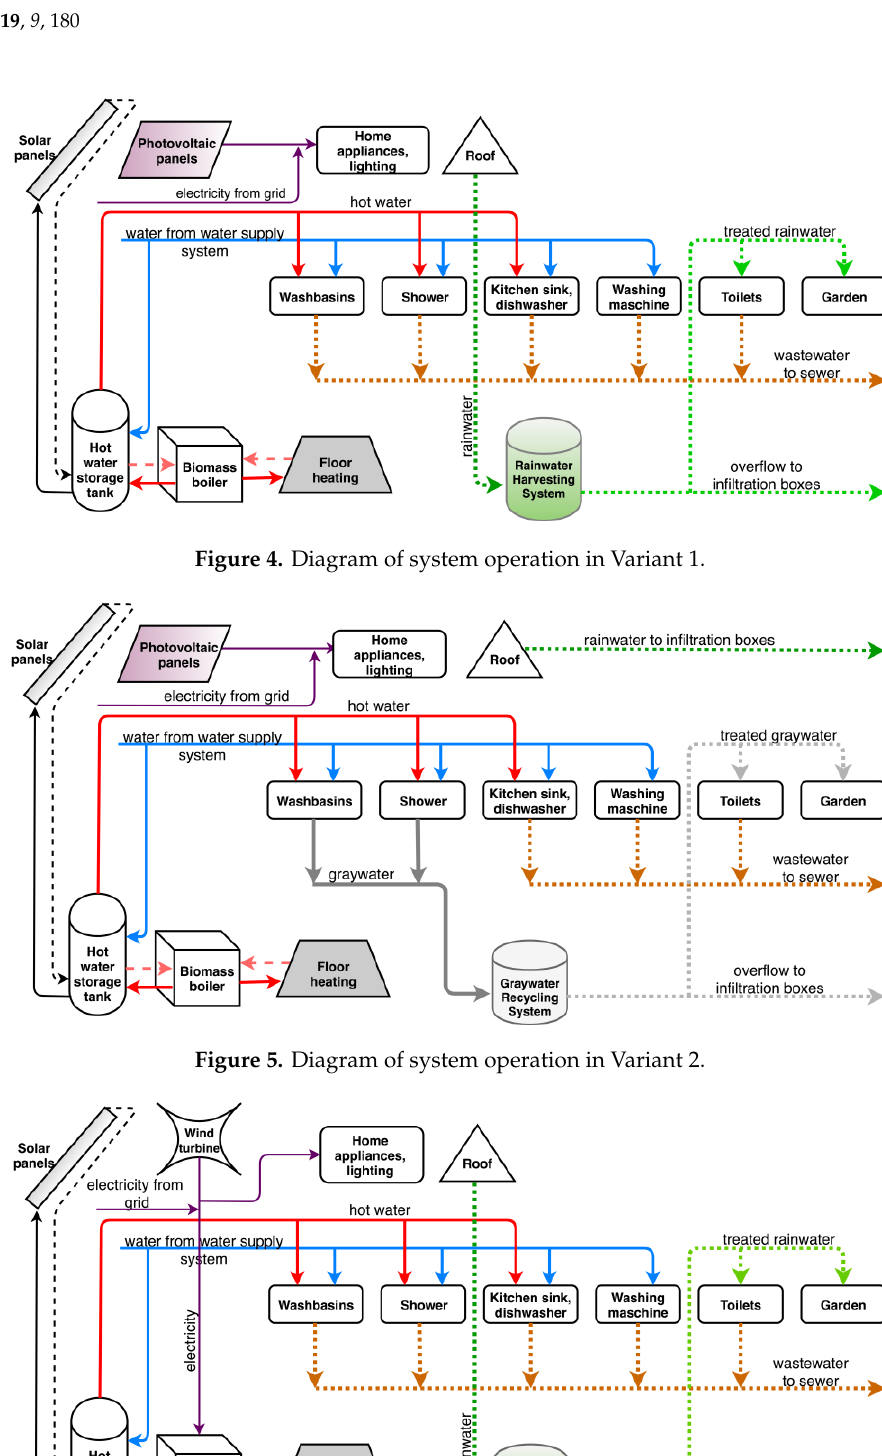
Figure 3. Diagram of system operation in Variant 0.